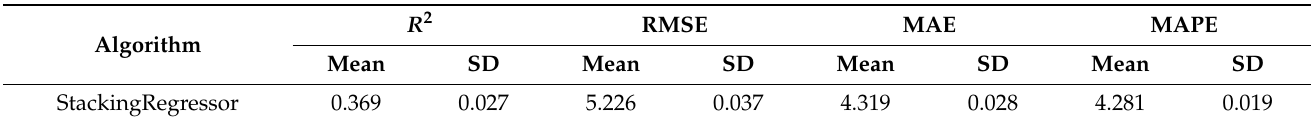
Table 4. Results of 10-fold cross-validation for the most efficient algorithms on the test dataset. SD ( × 10 − 4 ) is the standard